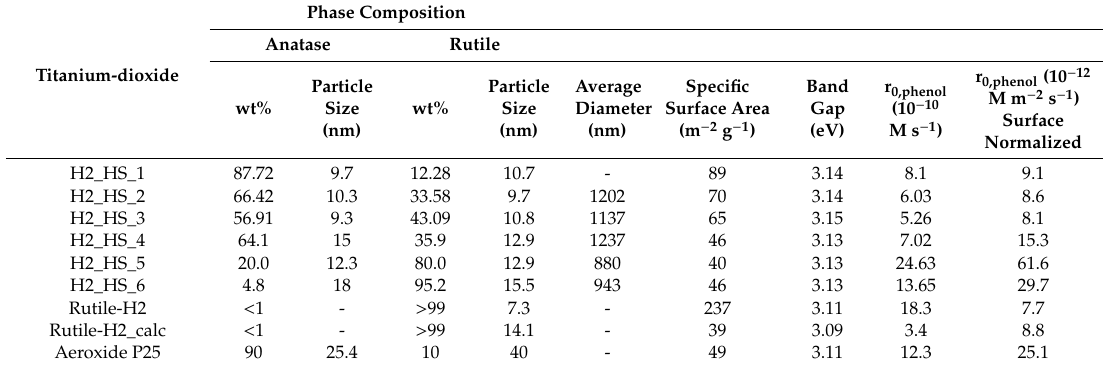
Table 2. Phase composition, average primary particle sizes, band gaps, and specific surface areas of the investigated TiO 2 -s.